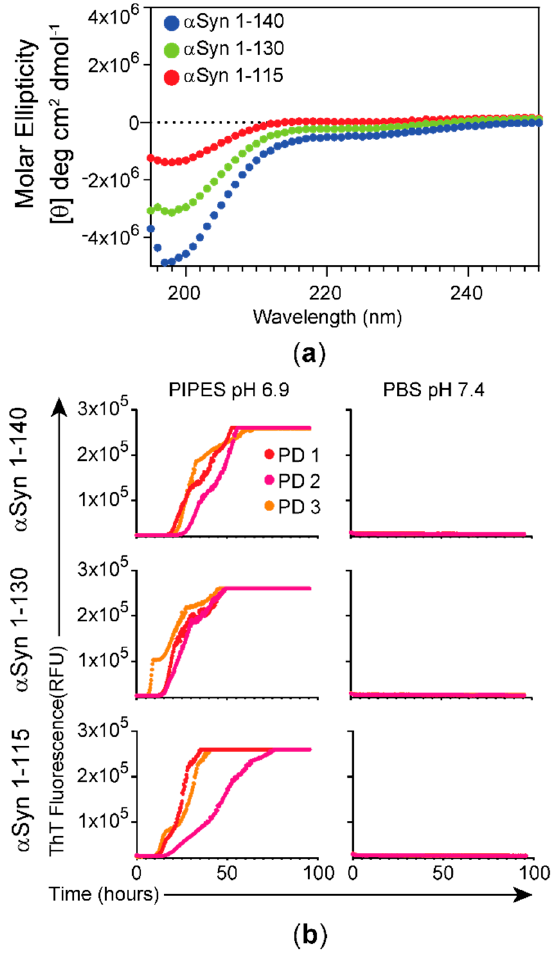
Figure 1. Characterization of α Syn monomeric substrates and RT-QuIC assay reaction buffer. ( a ) The secondary structure of the three monomeric recombinant α Syn forms tested by circular dichroism (CD) show a minimum mean residue ellipticity at 195 nm, typical of disordered proteins with random coil. ( b ) Effect of RT-QuIC reaction buffer on α Syn seeding activity. The RT-QuIC assay was performed in two different reaction mixtures (PIPES or PBS) for α Syn 1-140, α Syn 1-130, or α Syn 1-115 as substrates and the TBS fractions extracted from the temporal cortex samples from PD patients (n = 3) as seeds. The curve from each PD patient is the average of 3 technical replicates.